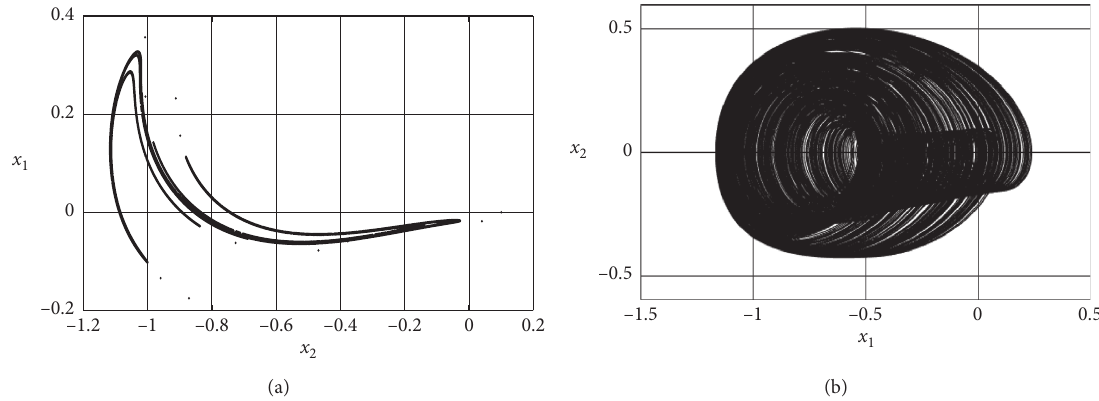
Figure 4: (a) Poincar´e map and (b) phase planet with r � 0.1, a � 1.6, b � 0.05, c � 0.35, d � 4 / 27, e � 0.0001, Γ � 0.2, p � 0.009, Ω � 1.0, and β � 0.01818.